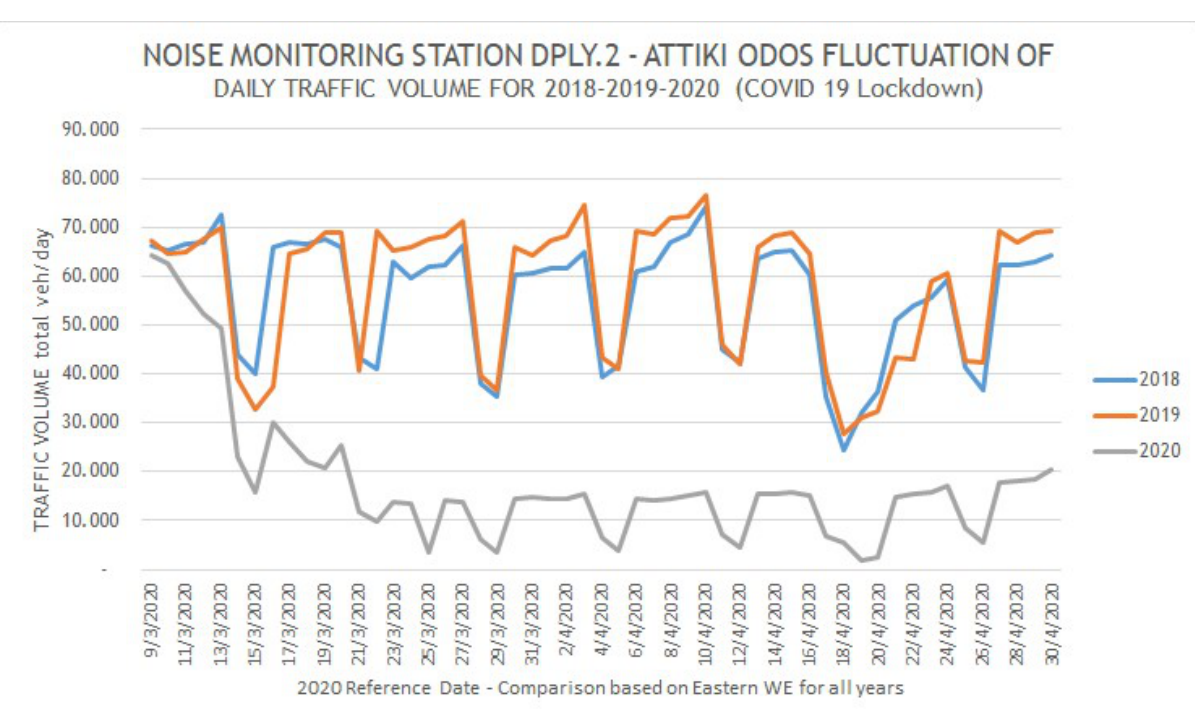
Figure 8h: Daily traflc volume – Noise monitoring station